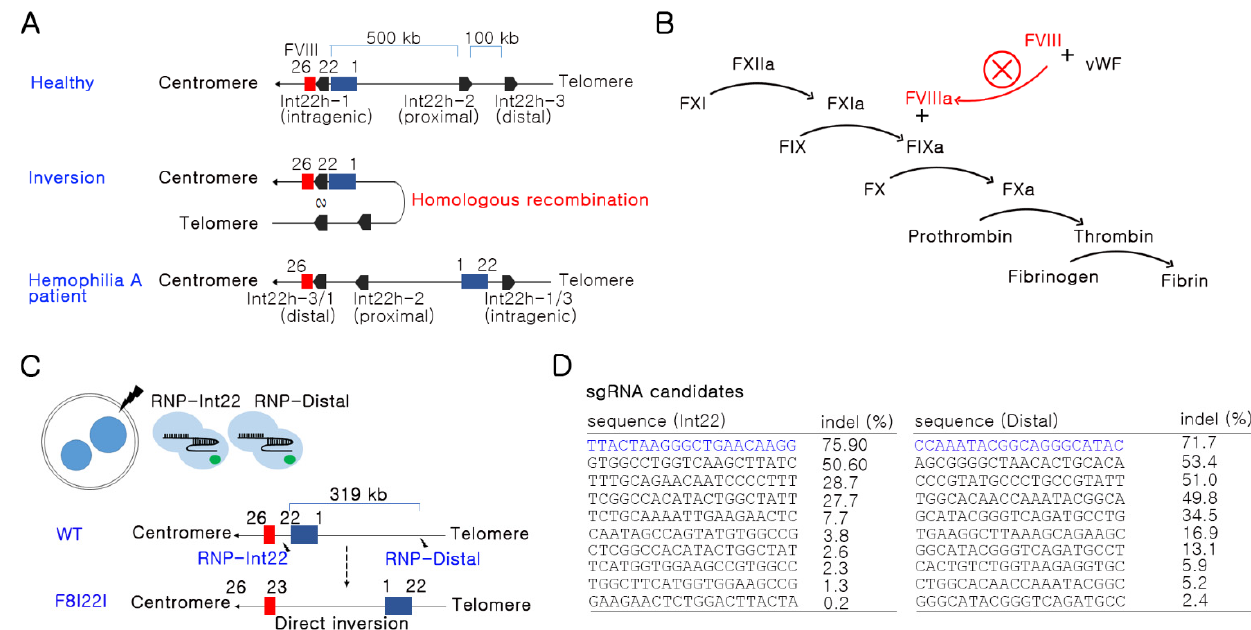
Figure 1. Strategy for Factor 8 intron 22 inversion (F8I22I) mouse generation. ( A ) Mechanism of F8I22I in human hemophilia A. ( B ) Brief coagulation pathway related to FVIII activation and consequent coagulation disorder. ( C ) Brief schematic for inversion-based HA model mouse generation. Two sgRNAs and Cas9 protein were transfected into mouse embryos using electroporation. The distance between the two target sites is approximately 319 kbps. Black lightning bolt: target site, blue box: F8 exon 1–22, red box: F8 exon 23–26. ( D ) sgRNAs with high DNA breakage potential were selected after screening using RNP transfection into NIH3T3 cell line and deep sequencing.